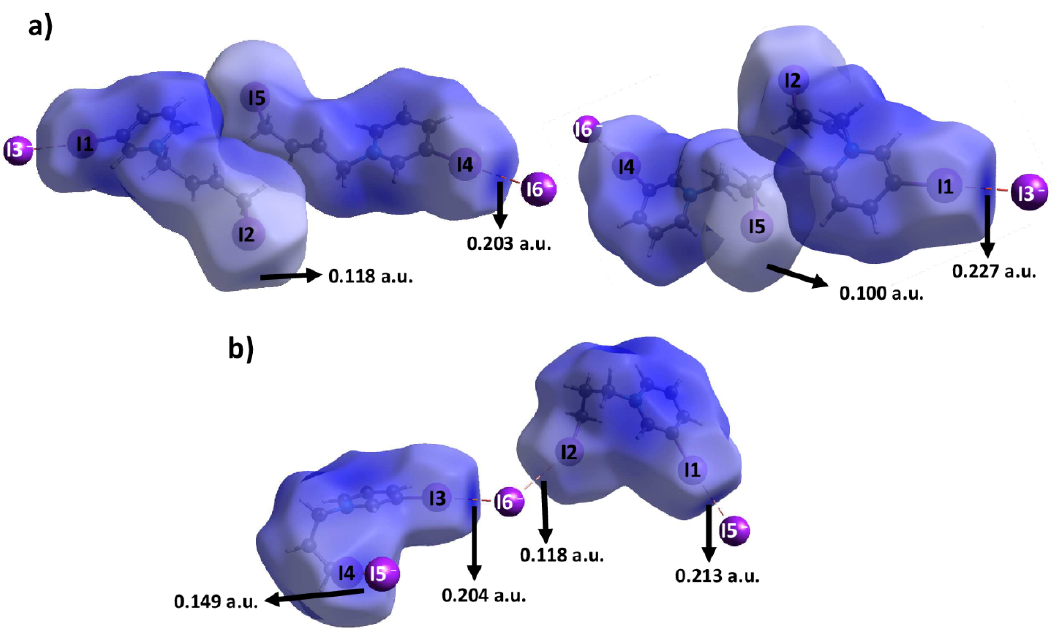
Figure 9. Hirshfeld surface with mapped ESP (computed on B3LYP-DGDZVP level of theory) for: ( a ) [ N -I Buen -( 3-IPy )] +